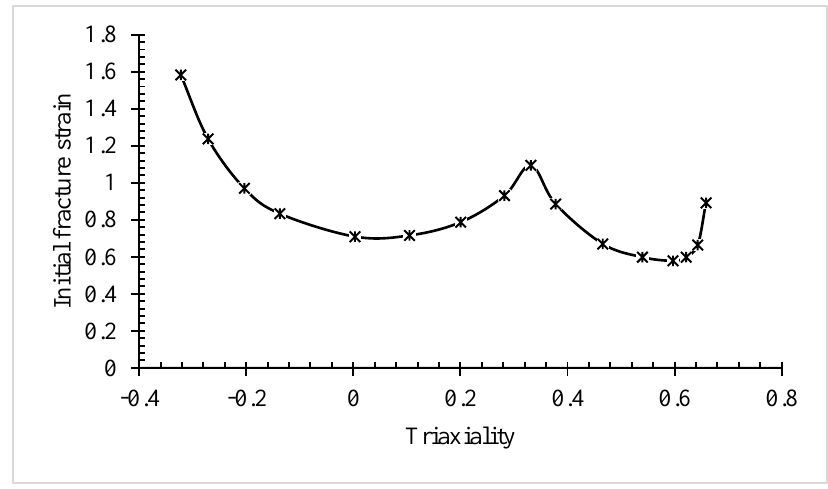
Figure 6. Fracture strain and triaxiality relation for DP600 steel.